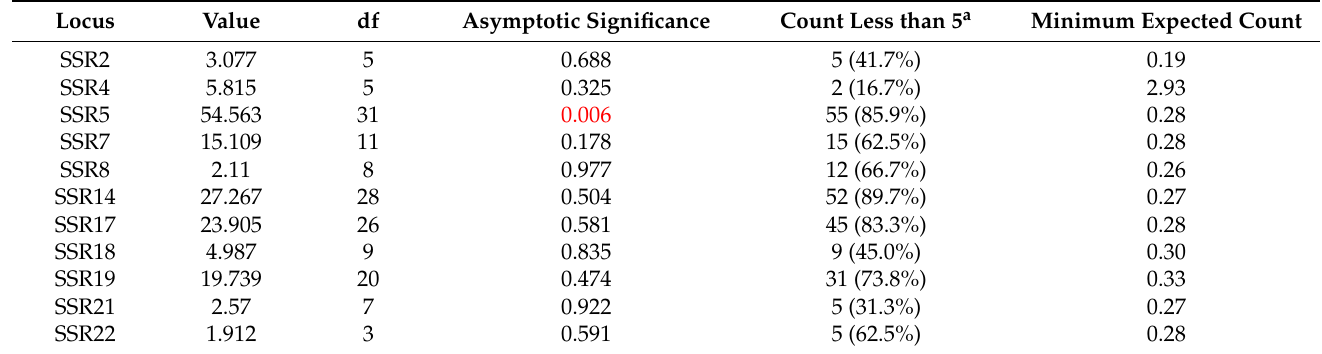
Table 3. Correlation analysis of SSRs and survival rate by chi-square test in strain B. Total of 11 loci, only 1 of the 11 SSR (SSR5) that is statistically significant ( p < 0.05). Df means degrees of freedom.